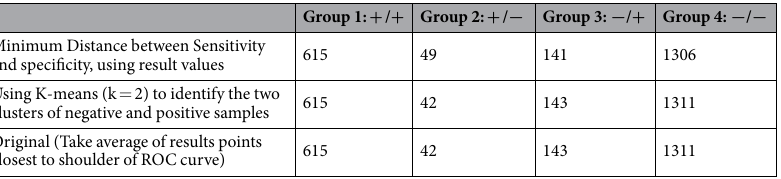
Table 3. Rates of Seroreversion and Seroconversion when the cut-off values for antibody positivity are selected using different methods.